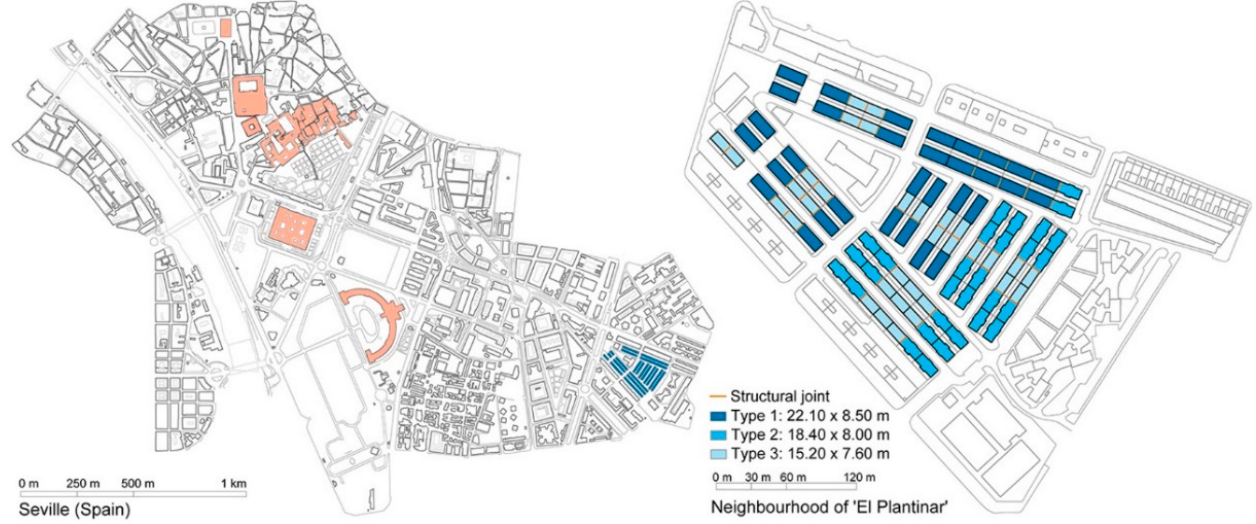
Figure 2. Case study neighbourhood and building